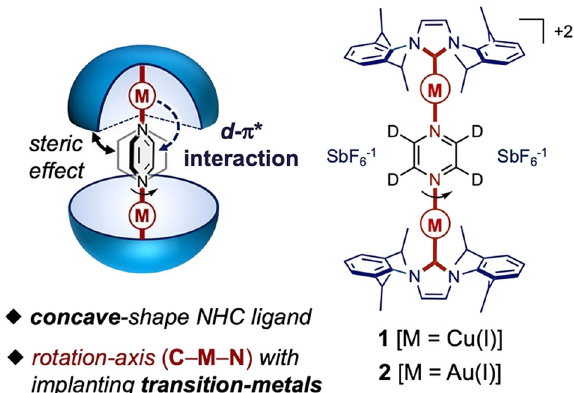
Fig. 1 N ‑ heterocyclic carbene complexes serve as molecular gyroscopes. Binuclear Cu(I) and Au(I) complexes of 1,3-bis(2,6-diisopropylphenyl) imidazol-2-ylidene ligands bridged by deuterated pyrazine provide a scaffold for 2-fold rotational motion in luminescent amphidynamic